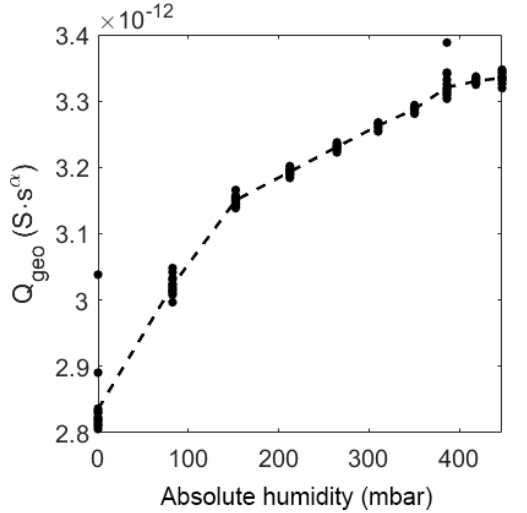
Figure 8. Exponents of every CPE over absolute humidity at 320 ◦ C. The dots represent the value of the fit of each measurement. The dashed lines represent the mean of the dots.